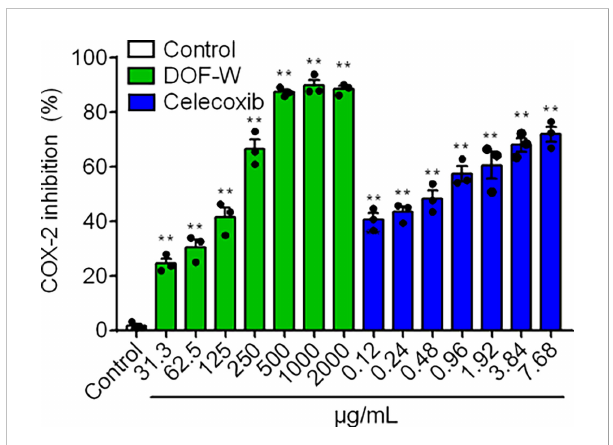
FIGURE 3 COX-2 inhibition of DOF-W. Compared with the control, ** p< 0.01.